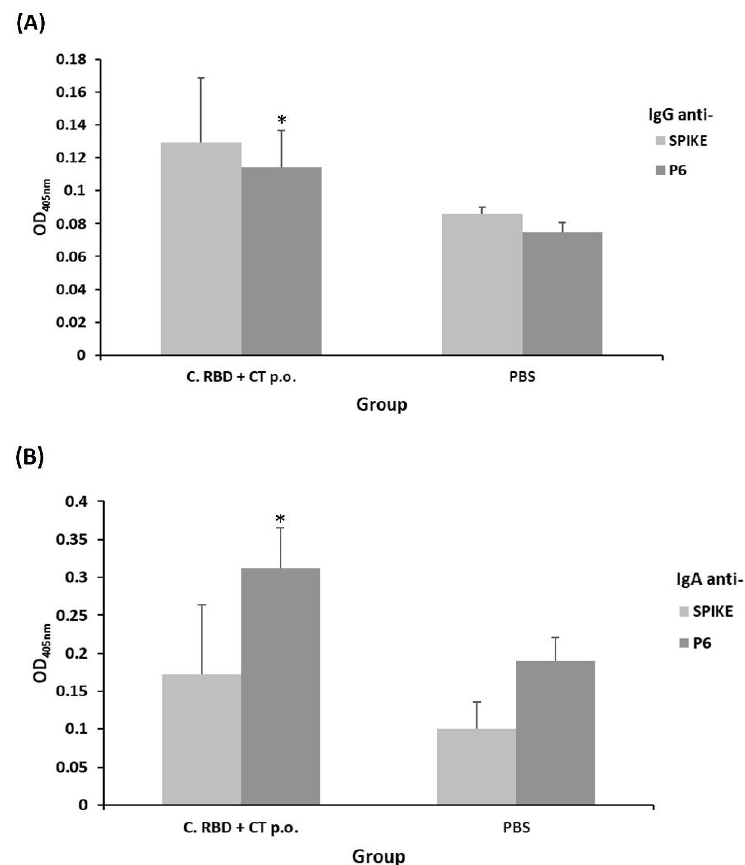
Figure 6. Evaluation of intestinal humoral response (IgA and IgG) induced by the algae-made RBD. IgG ( A ) and IgA ( B ) antibodies were measured in feces (1:2 dilution of the feces extract) by ELISA using either spike or P6 as the target antigen. Error bars represent standard deviations. * denotes statistically significant differences versus the PBS group ( p < 0.05).